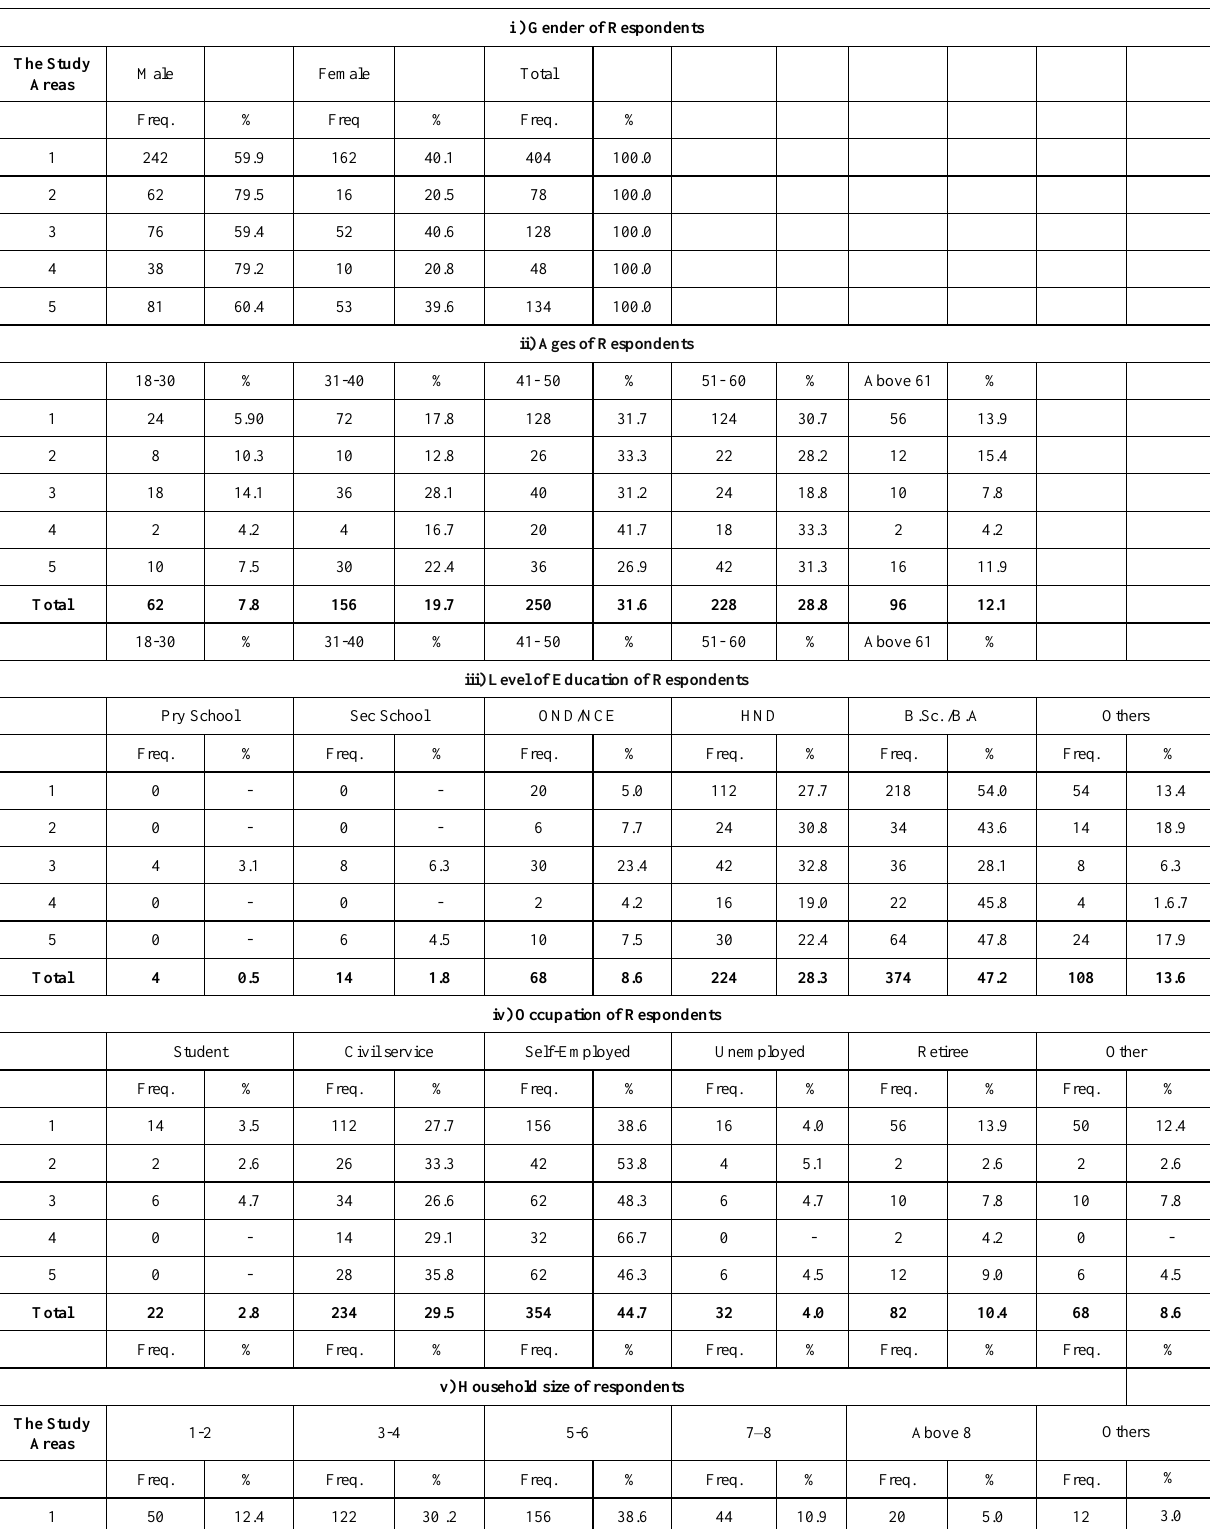
Table 3. Socio-economic Characteristics of